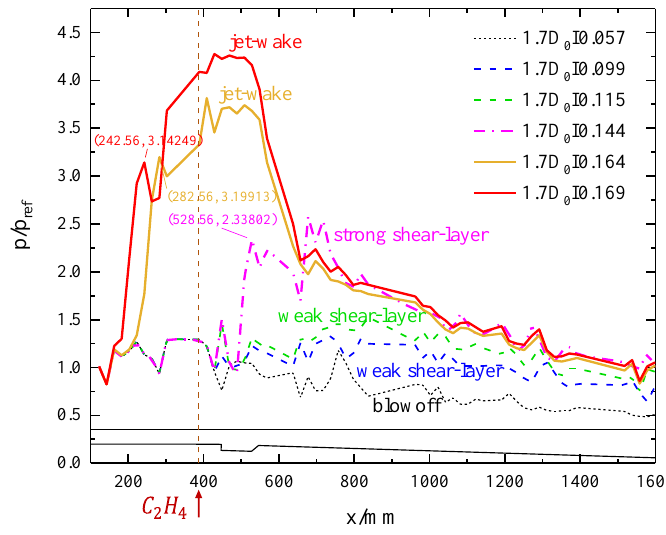
Figure 16. Dimensionless pressure along x axis at different ERs.